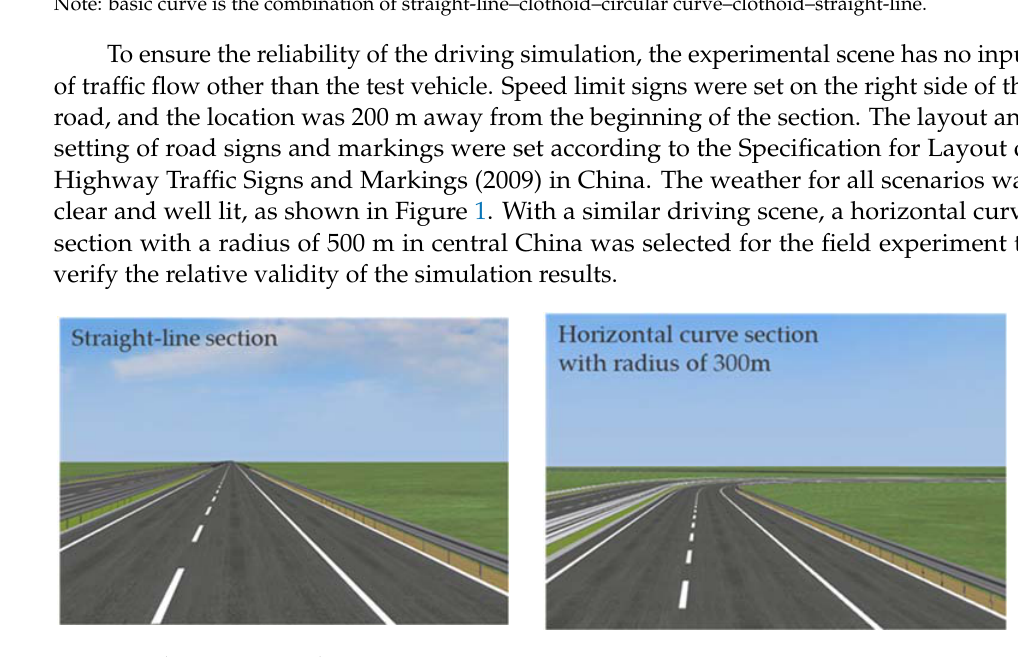
Figure 1. The experimental